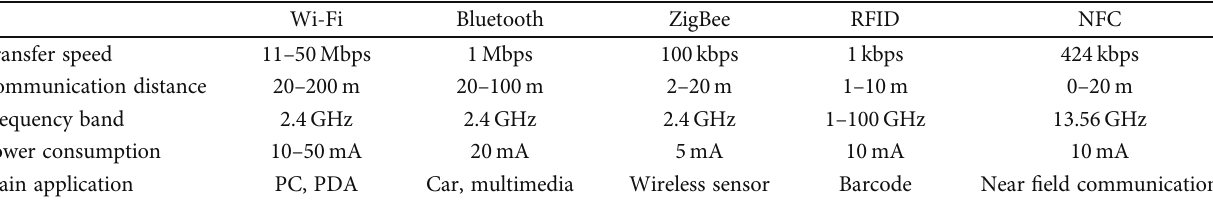
Figure 3: Composition of a database station. Table 1: Comparison of wireless communication